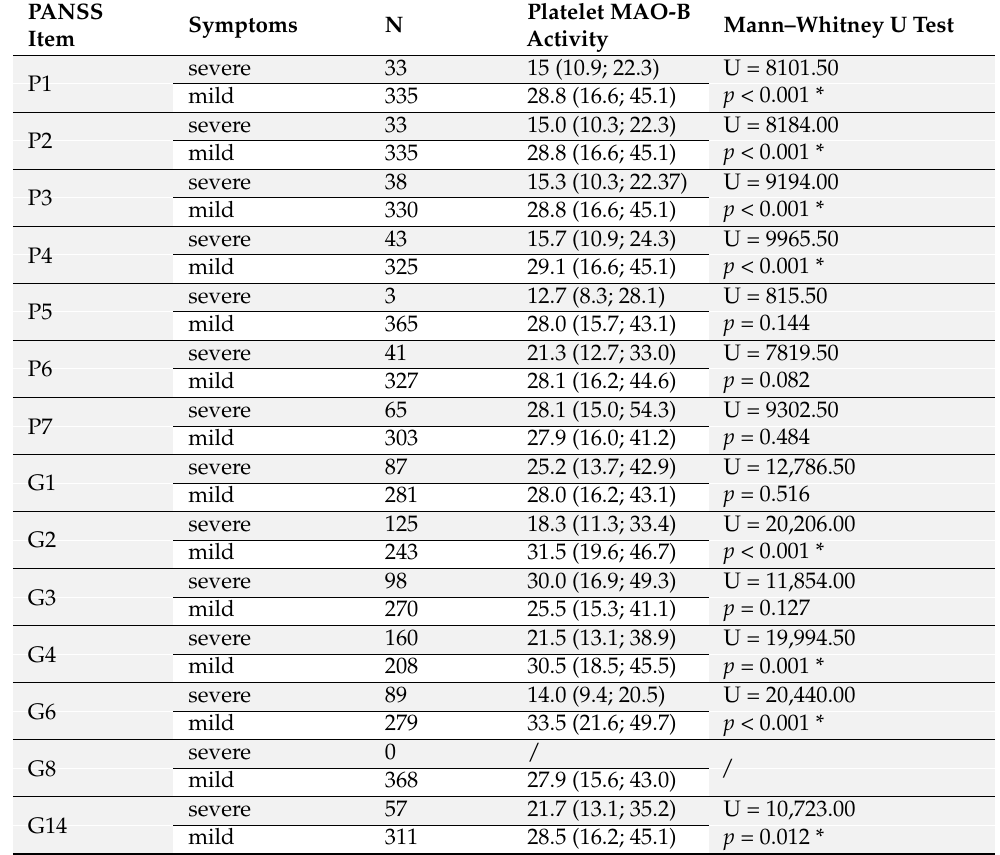
Table 3. Platelet MAO-B activity in smokers with PTSD subdivided into those with severe or mild symptoms evaluated by specific PANSS items.